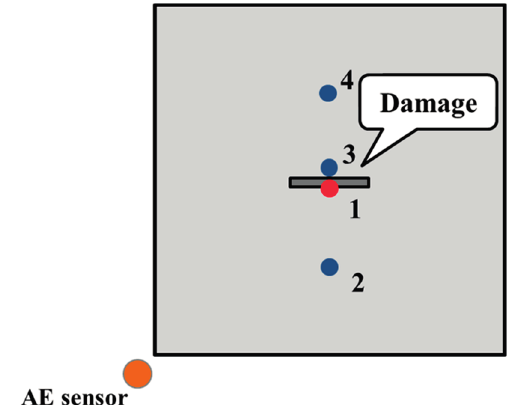
Figure 5. Positions of four inspection points.